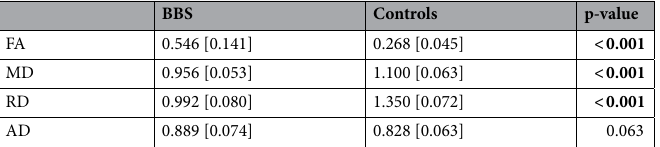
Table 3. Corticomedullary differentiation, reported as median and interquartile ranges (in square brackets), which were calculated as the ratios between cortical and medullary mean values for each DTI parameter. FA: fractional anisotropy; MD: mean diffusivity; RD: radial diffusivity; AD: axial diffusivity; BBS: Bardet-Biedl syndrome. p-values < 0.05 are presented in bold.